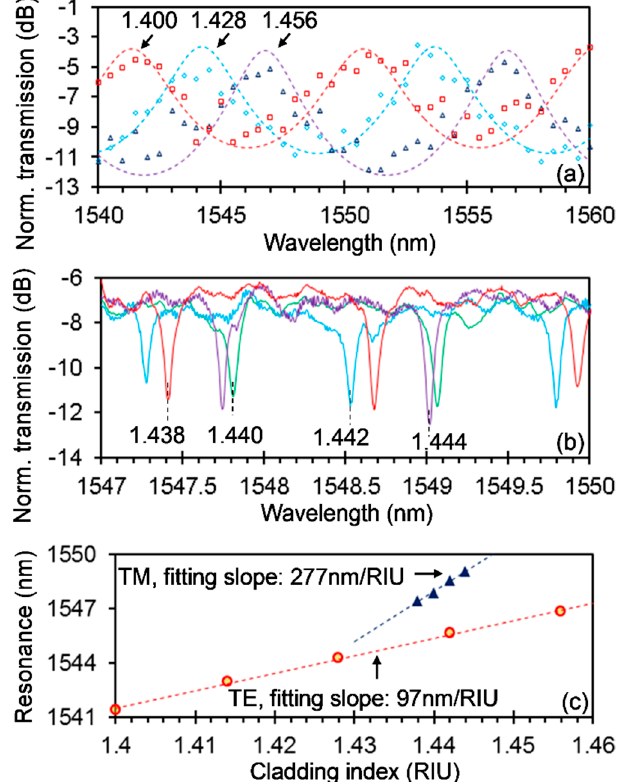
Figure 6. The fabricated silicon photonic polarization multiplexing sensor for refractive index sensing of the cladding analyte. Measured spectra at different cladding refractive indexes (RIs) for the TE ( a ) and TM ( b ) modes. For TE mode, the measurement results are shown with open markers, and fitting curves are shown with dashed lines, while for TM mode, only the measurement results are shown. ( c ) Resonant wavelength with respect to the cladding RI. Linear fittings (dashed lines) and slope values are also shown in ( c ).